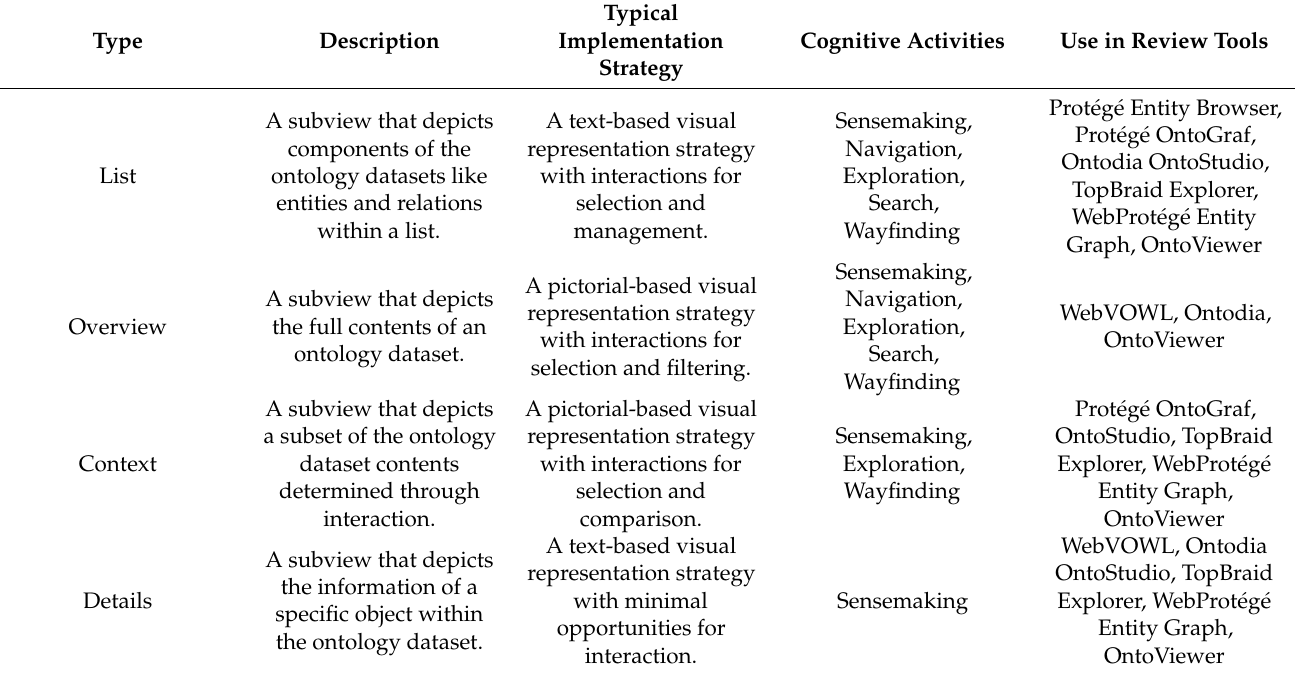
Table 3. The types of subviews within an ontology dataset visualization